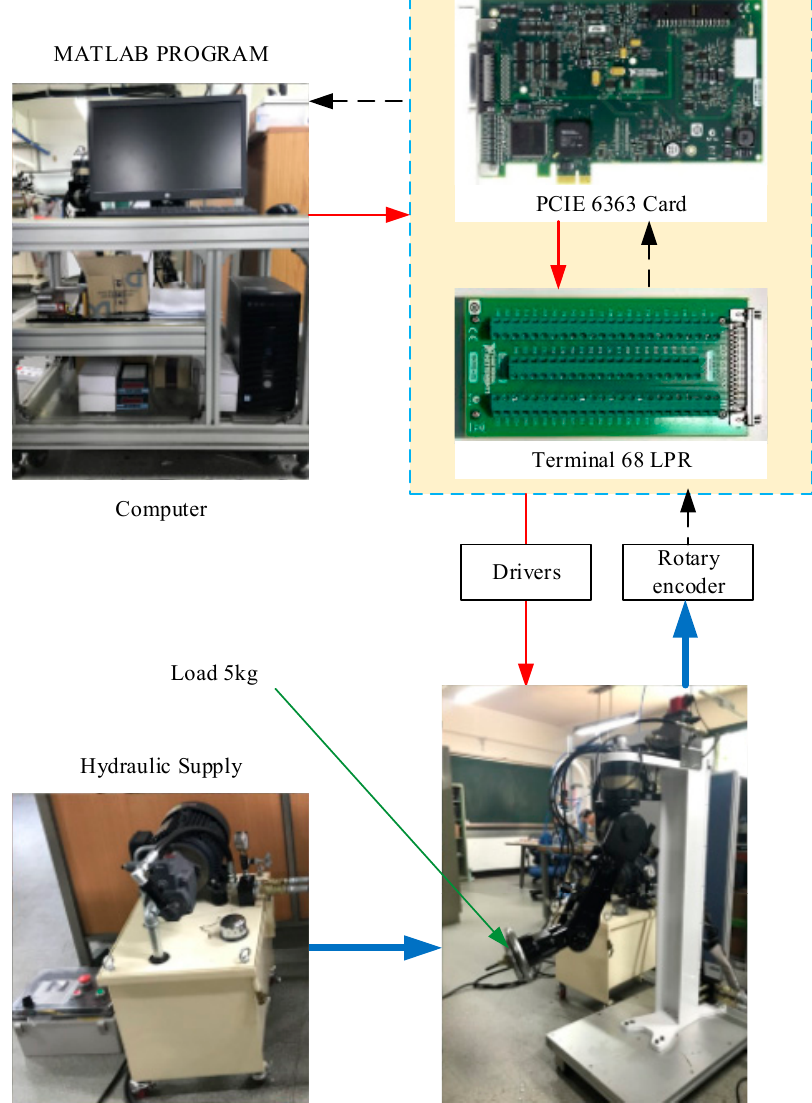
Figure 21. Setup test bend for experiments.